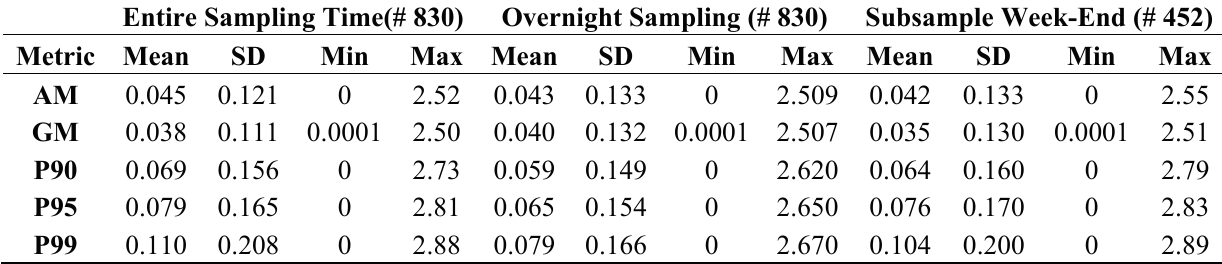
Table 2. ELF-MF level ( μ T) in the child’s bedroom among controls with valid